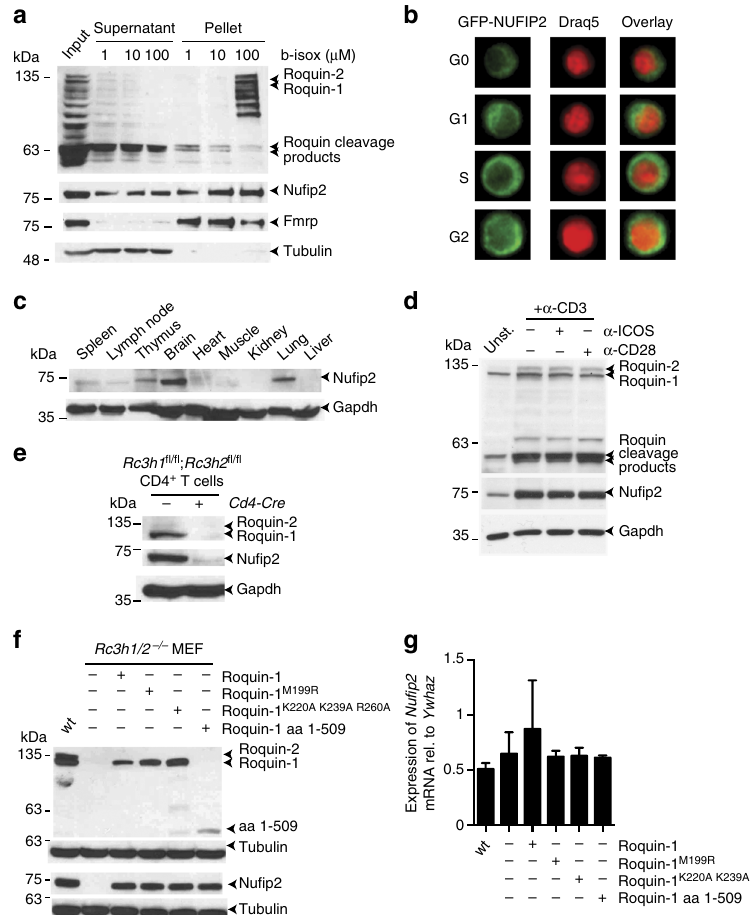
Fig. 4 Nu fi p2 protein is stabilized by Roquin. a Immunoblot analysis of Roquin, Nu fi p2, and Fmrp proteins in MEF lysates and supernatants or precipitates of b-isox-treated extracts. b Flow cytometry imaging analysis of GFP-Nu fi p2 localization in activated Th1 cells from Rc3h1 fl / fl ; Rc3h2 fl / fl ; Cd4-Cre-ERT2 ; rtTA mice. Before analysis, retrovirally transduced cells were treated with doxycycline for 24 h to induce GFP-NUFIP2 expression. c – f Immunoblot analysis of Nu fi p2 ( c ) or Nu fi p2 and Roquin ( d – f ) in c different mouse tissues, d mouse CD4 + T cells left untreated or stimulated for 12 h with ( α -CD3) alone or in combination with anti-CD28 ( α -CD28) or anti-ICOS ( α -ICOS), e mouse CD4 + T cells with ( Rc3h1/2 fl / fl ) or without ( Rc3h1/2 fl / fl ; Cd4-Cre ) Roquin expression, or f in lysates from wild-type and Roquin – de fi cient MEF cells, reconstituted with wild-type or Roquin-1 mutants as indicated. Gapdh ( c – e ) or α - tubulin ( f ) served as loading controls. g qPCR analysis of Nu fi p2 mRNA expression in cells from f . Expression was calculated relative to the reference gene Ywhaz and normalized to untransduced cells. Error bars in g represent mean and SD of two independent experiments. In a , b , d , e and f representatives of two ( d , e , f ) or three ( a , b ) independent experiments are